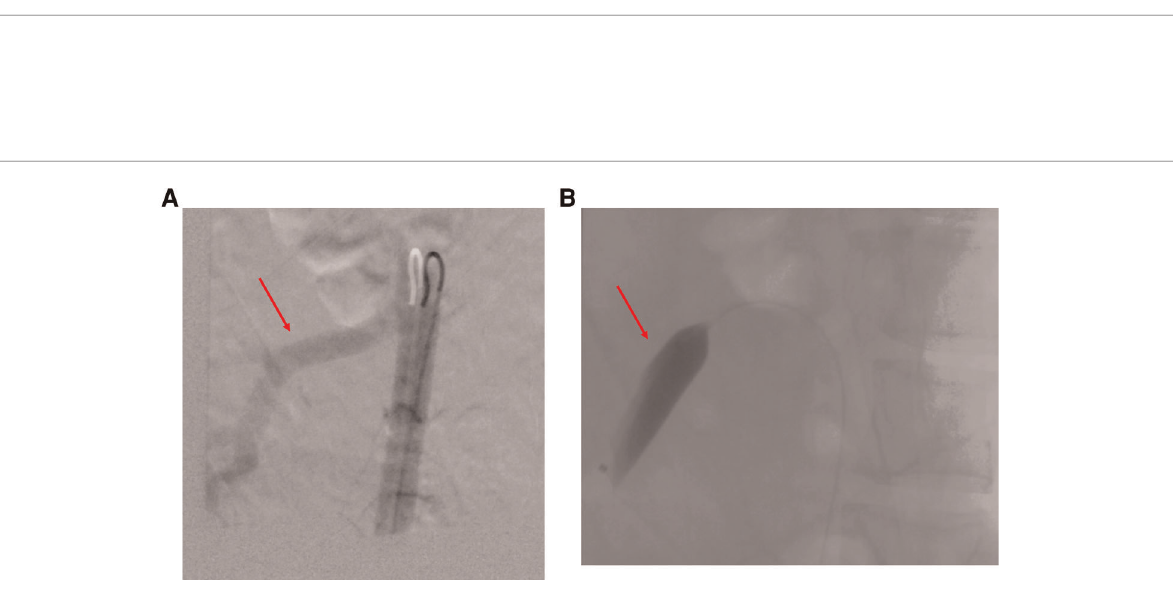
FIGURE 1 Preoperative contrast-enhanced computed tomography of the abdomen: ( A ) axial plane (red arrow: right renal angiomyolipoma); and ( B ) sagittal